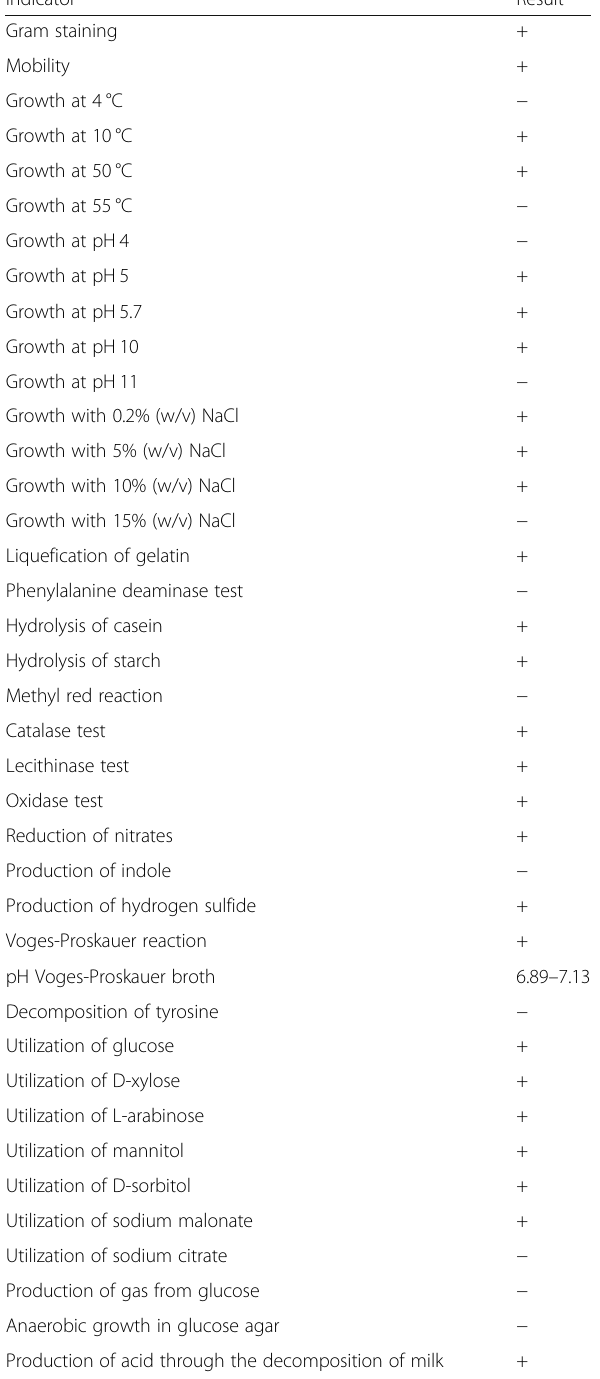
Table 1 Antifungal activities of rhizobacteria isolates against C . gloeosporioides in vitro